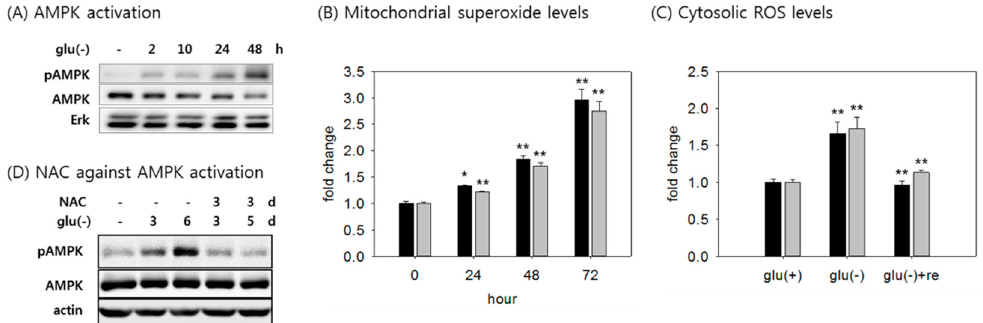
Figure 2. Activation of AMPK by increased ROS level. ( A ) Cells were incubated in glucose-free medium for the indicated time, and the activity of AMPK was detected by immunoblot analysis with antibodies against phospho-AMPK and AMPK; ( B ) for the measurements of mitochondrial and cytosolic superoxide, cells were glucose-deprived for the indicated time, stained with mitoSOX (black bar) and dihydroethidium (DHE) fluorescent dyes (grey bar), and more than 1 × 10 4 cells were analyzed by flow cytometry. The levels of signal at each time point was determined in at least three biological repeats; ( C ) mitochondrial and cytosolic ROS were detected using DHR123 (black bar) and DCF (grey bar) fluorescent dyes, respectively. To measure the effect of glucose replenishment on the cellular ROS levels, cells were cultivated in glucose-free medium for three days, and then supplied with glucose for one day; ( D ) Cells were incubated in glucose-free medium with 5 mM N-acetylcysteine (NAC) for the indicated time period. Cells of lane 5 were treated with NAC for the last three days of withdrawal. Cells were lysed and subjected to immunoblotting with antibodies against phospho-AMPK and AMPK. Values are presented as mean ± s.d. * p <0.05; ** p < 0.01 by ANOVA.